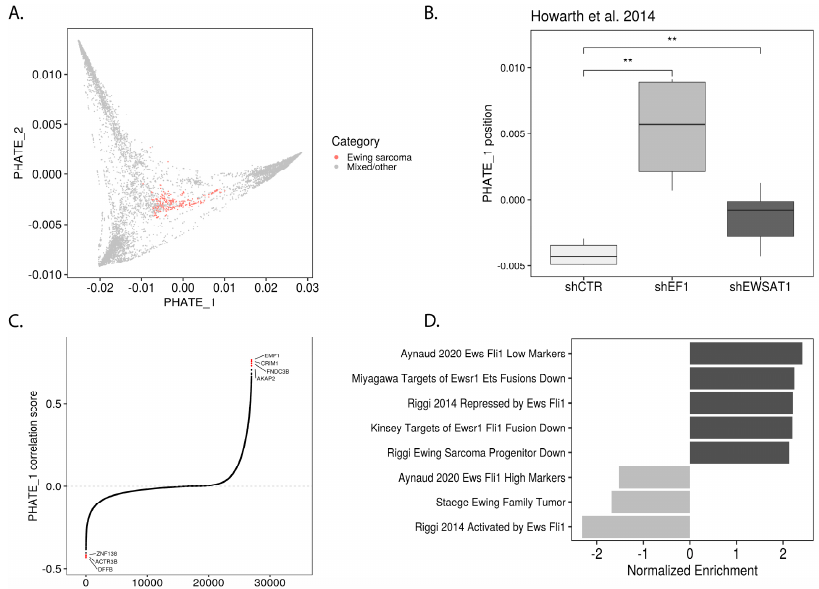
Figure 3. Ewing sarcoma’s position in underlying developmental trajectory controlled by EWSR1-FLI1 expression levels: ( A ) PHATE embedding with Ewing sarcoma samples highlighted; ( B ) Box-plot showing difference in location along PHATE_1 between A673 cells exposed to control shRNA or shRNA targeting EWSR1-FLI1 (shEF1) and Ewing sarcoma associated transcript 1 (EWSAT1) [15] (one-tail t test, ** p ≤ 0.01); ( C ) Genes in Ewing sarcoma samples ranked by PHATE_1 correlation score (signed R 2 ); ( D ) Bar-plot showing enrichment of Ewing sarcoma gene sets within PHATE_1 correlation scores as determined by